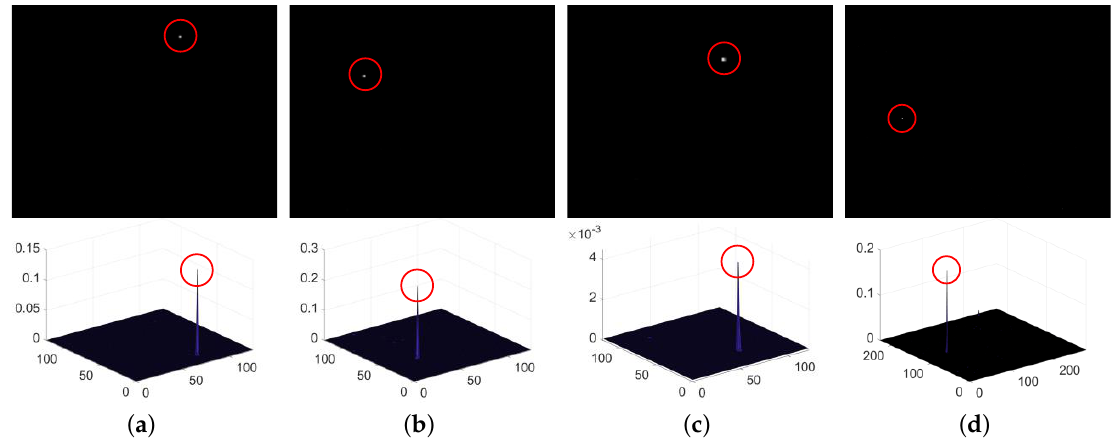
Figure 3. ( a – d ) are the confidence maps of the representative infrared images in Figure 2a–d. The first row shows the normalized gray image of the confidence maps and the second row shows the three-dimensional mesh images of the confidence maps. The red circles indicate where the ground-true targets